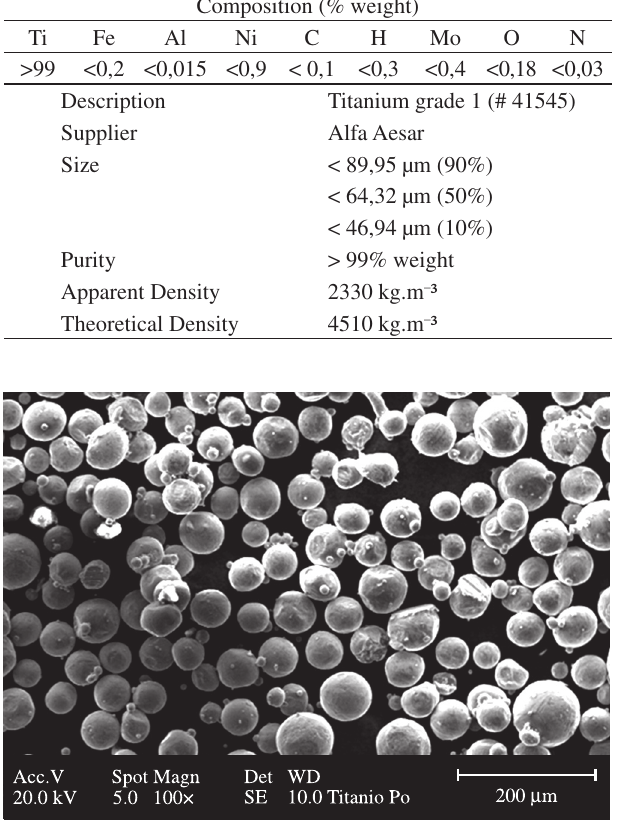
Figure 1. Size and shape of the titanium powder.